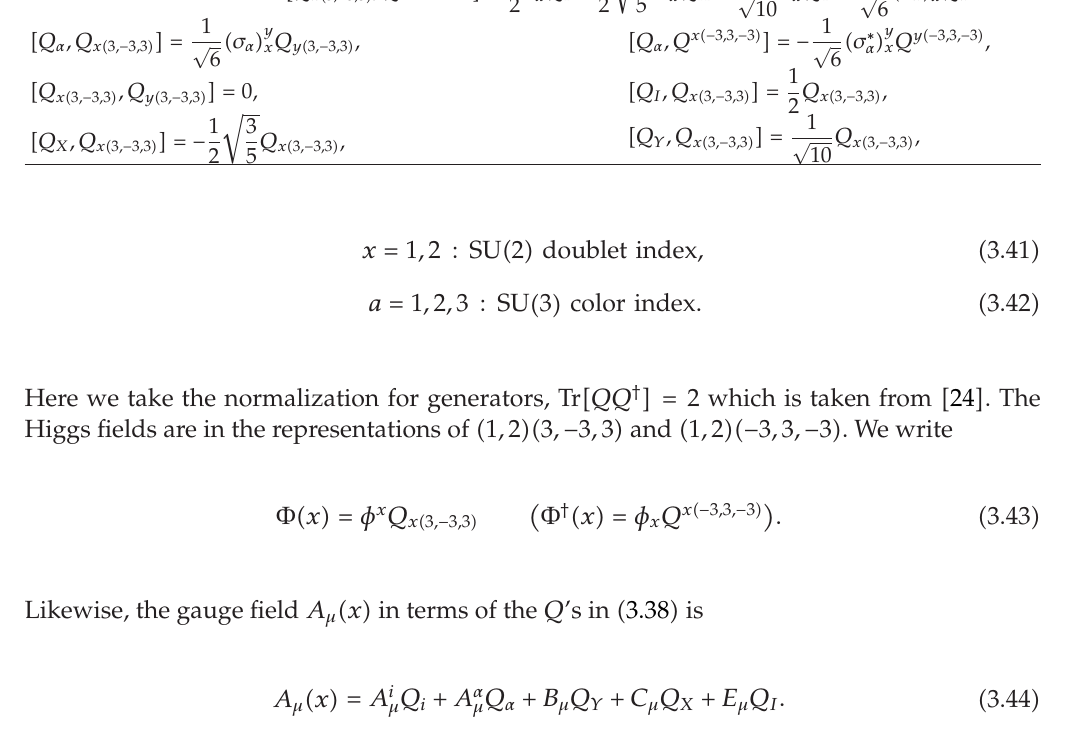
α , Q X,Y,I , Q x (cid:2) 3 , − 3 , 3 (cid:3) and Q (cid:4) Q y (cid:2) − 3 , 3 , − 3 (cid:3) (cid:5) (cid:6) x (cid:2) 3 , − 3 , 3 (cid:3) ,Q